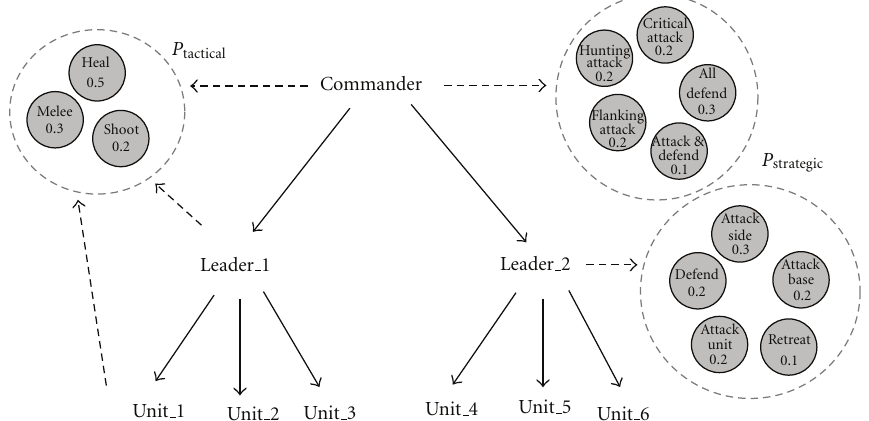
Figure 11: Experimental setup of the SAP hierarchical learning framework tests: units’ hierarchy. Each team in the experiment consists of one commander, two subteam leaders, and 6 units. All agents have the same type of tactical personality (with di ff erent weights), but the strategic personalities at each hierarchical level are made up of di ff erent